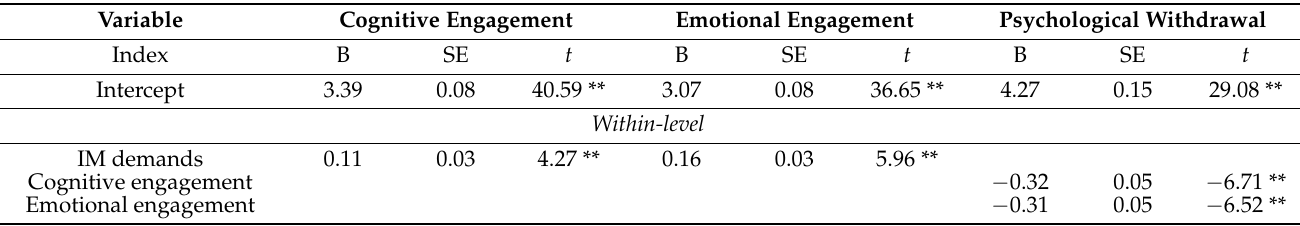
Table 3. Mediation effect of emotional engagement and cognitive